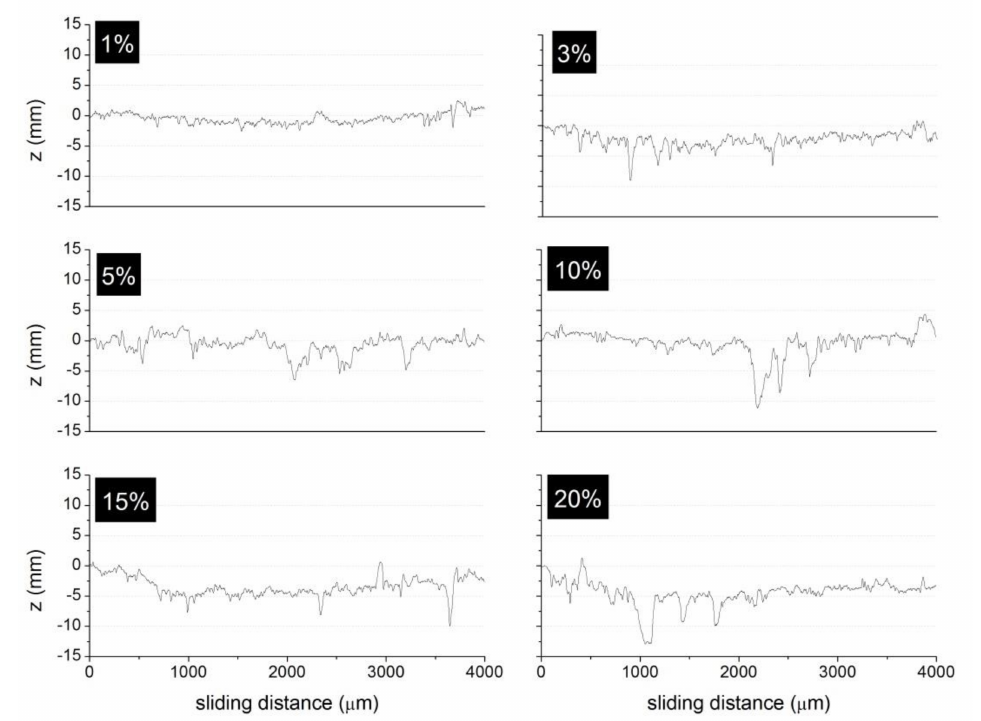
Figure 3. Surface profiles of the composite pad elements after the friction tests for 1%, 3%, 5%, 10%, 15%, and 20% wt. of A60 rubber